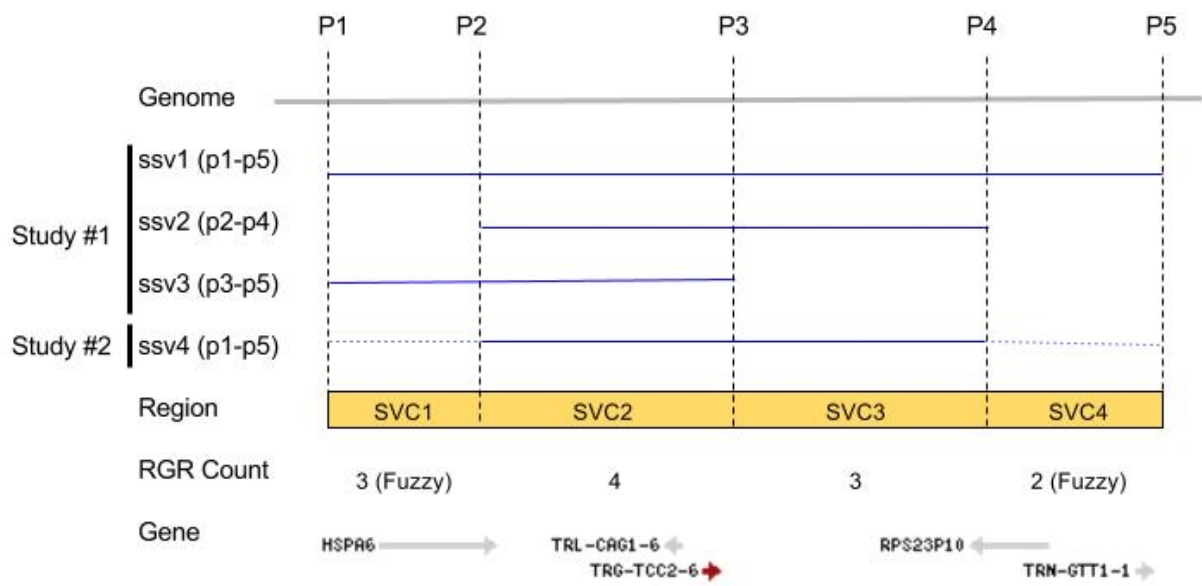
Figure 1. An alignment of variants ssv1-ssv3 (blue lines) with the genome (grey line) between positions P1 and P5. Reference genomic regions SVC1-SVC4 (yellow box) are demarcated by overlap and non-overlapping positions (P1-P2, P2-P3, etc.) between SSVs. The observed SVC counts and the genes are shown on the